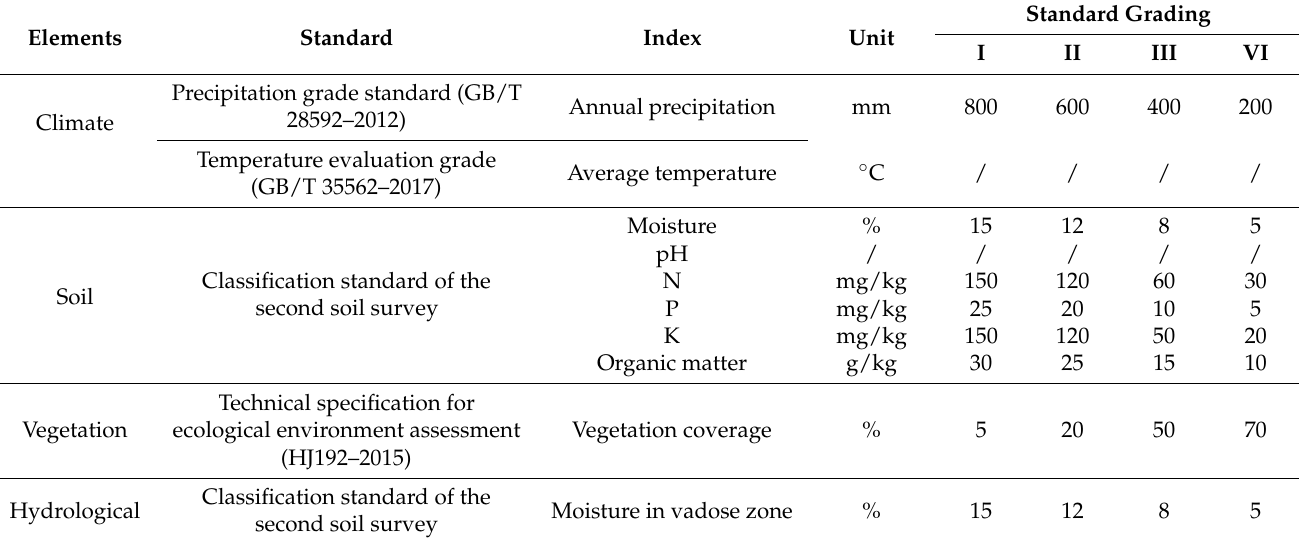
Table 1. Evaluation criteria of the environmental